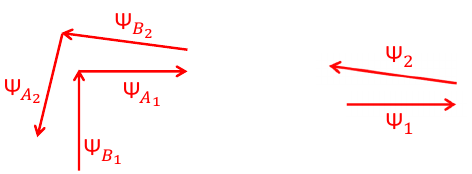
Figure 6. Yaw angle labels for the landmarks corner and stairs represented respectively in Figure